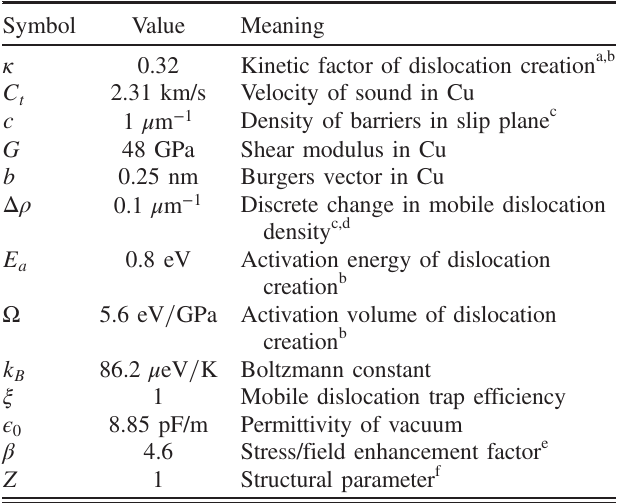
TABLE II. Constants and fitted parameters of the MDDF model